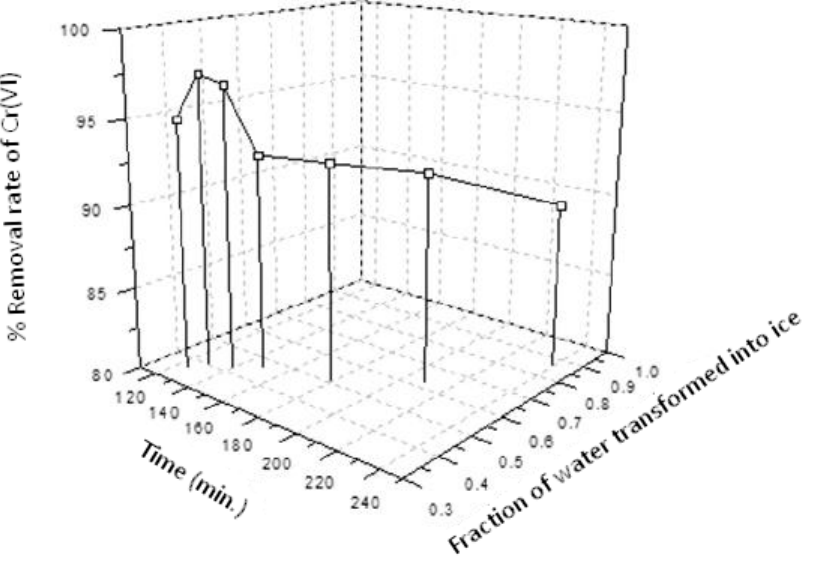
Figure 2. Relation between the fraction of water transformed into ice (V/V), percent Cr(VI) removed and freeze duration (conditions: deionized water with spiked Cr(VI) at initial concentration of 5 mg/L & freeze temperature of 249.15 K, initial volume 250 mL)